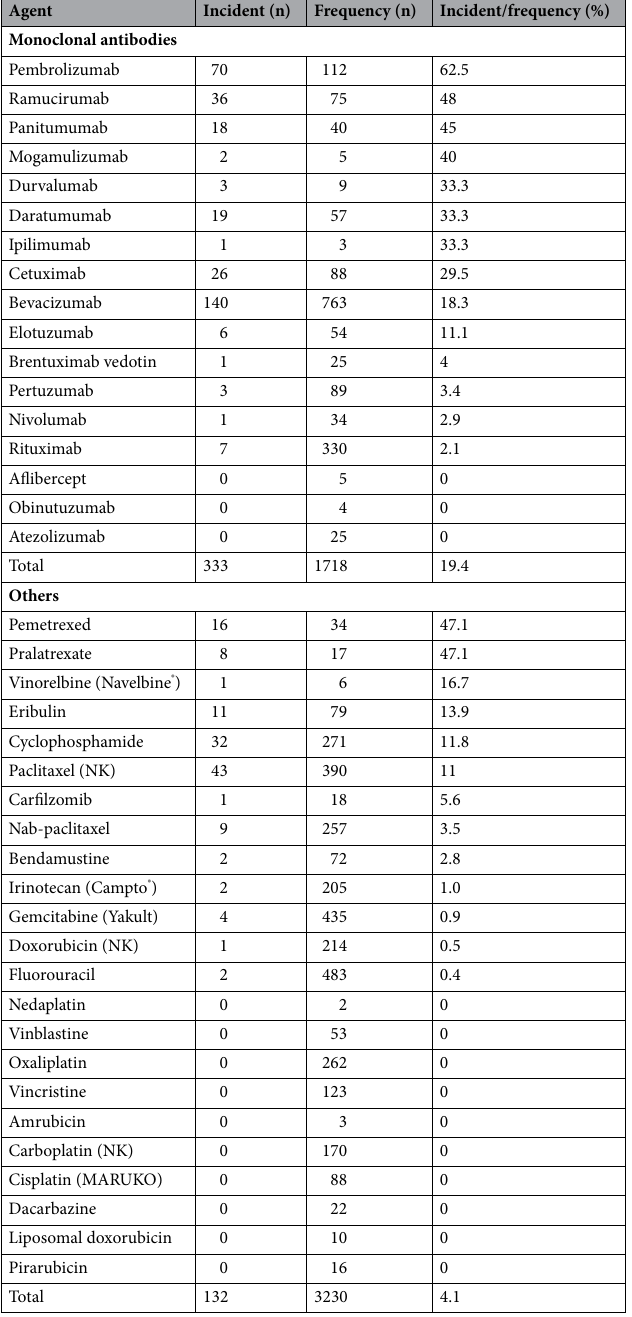
Table 1. Incidence of insoluble fine particles during preparation of anticancer agents at Ehime University Hospital (frequency = incident/preparation)